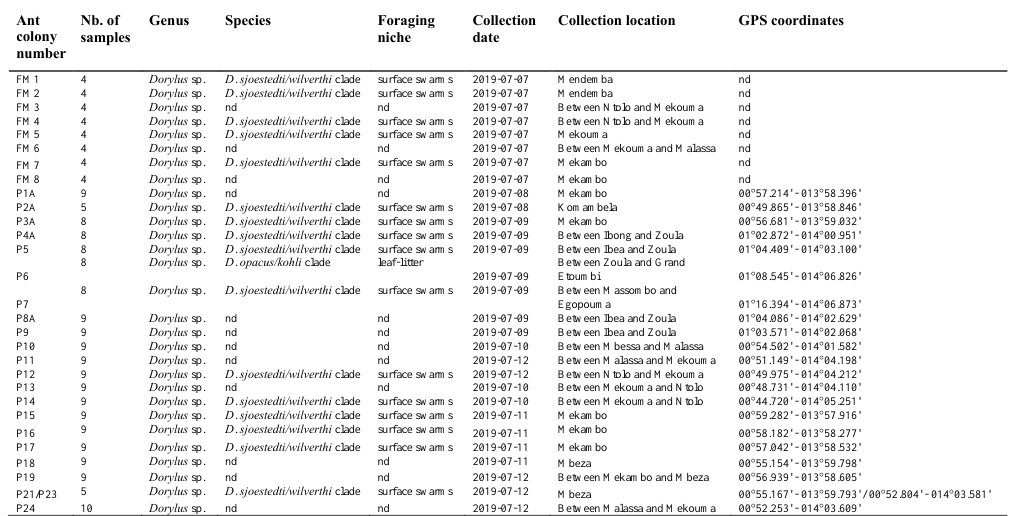
Table 1 – Characteristics of the army ant samples. P21/P23 means that colonies P21 and P23 were pooled. The species assignation is based on Cytochrome oxidase I reads and contigs analysis. “nd” means non